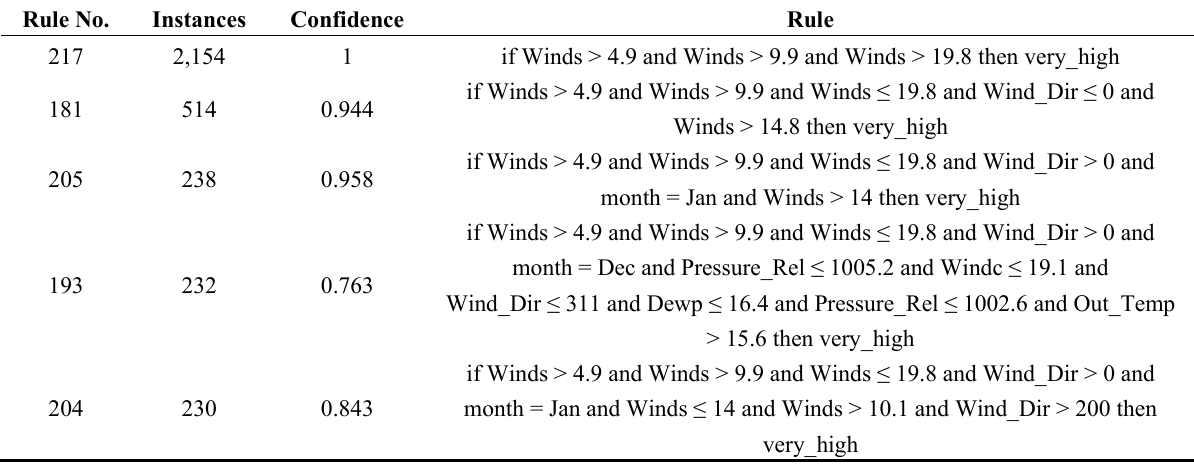
Table 5. C5.0 rules with top nine highest instances for very high